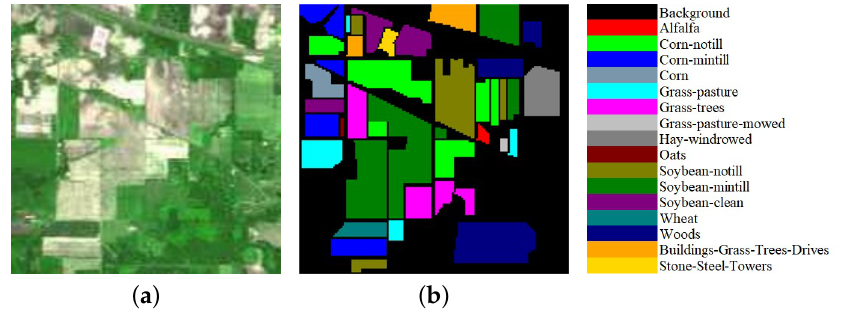
Figure 5. ( a ) False-color Indian Pines image. ( b ) Ground-truth map of the Indian Pines data set.